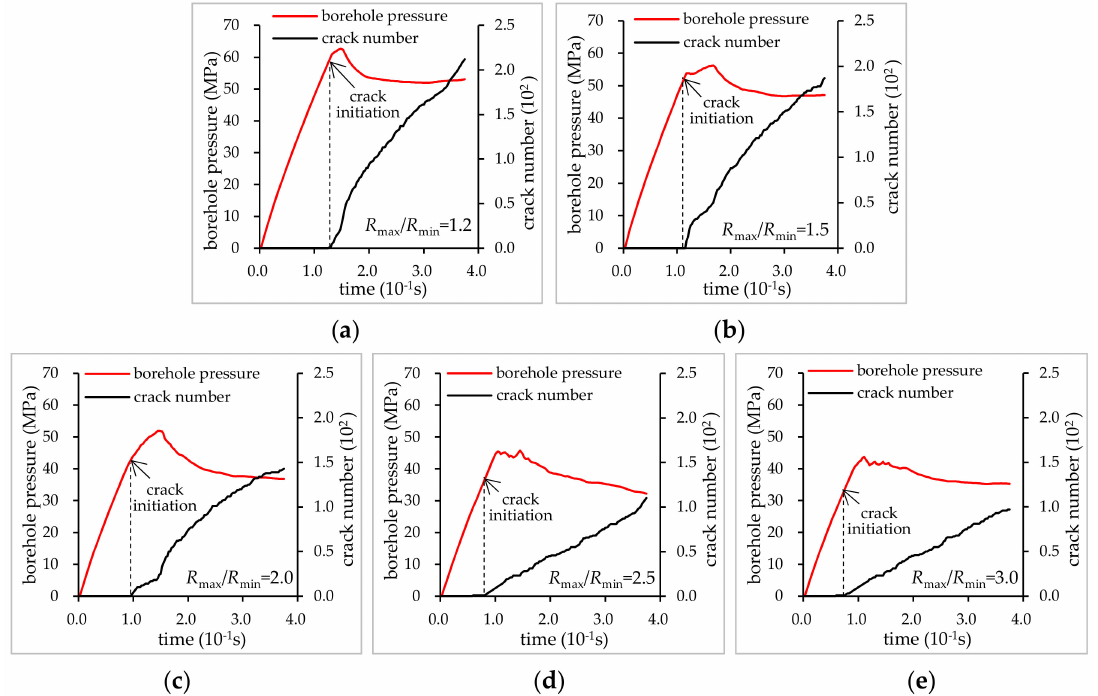
Figure 9. Borehole pressure curves under different size ratios and the determination of crack initiation ( S H = S h = 10 MPa) ( a ) R max /R min = 1.2; ( b ) R max /R min = 1.5; ( c ) R max /R min = 2.0; ( d ) R max /R min = 2.5; ( e ) R max /R min =